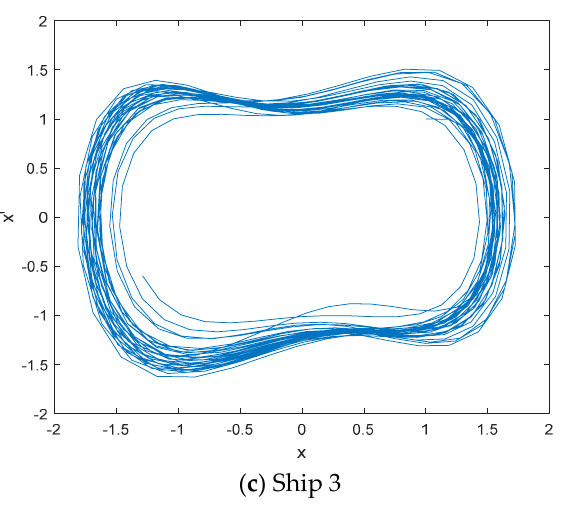
Figure 12. The great periodic states of IMF8 for three kinds of ship-radiated noise samples. Table 9. The frequency distribution of IMF8 by VMD-DCO-KPE for three kinds of ship-radiated noise samples. Ship 1